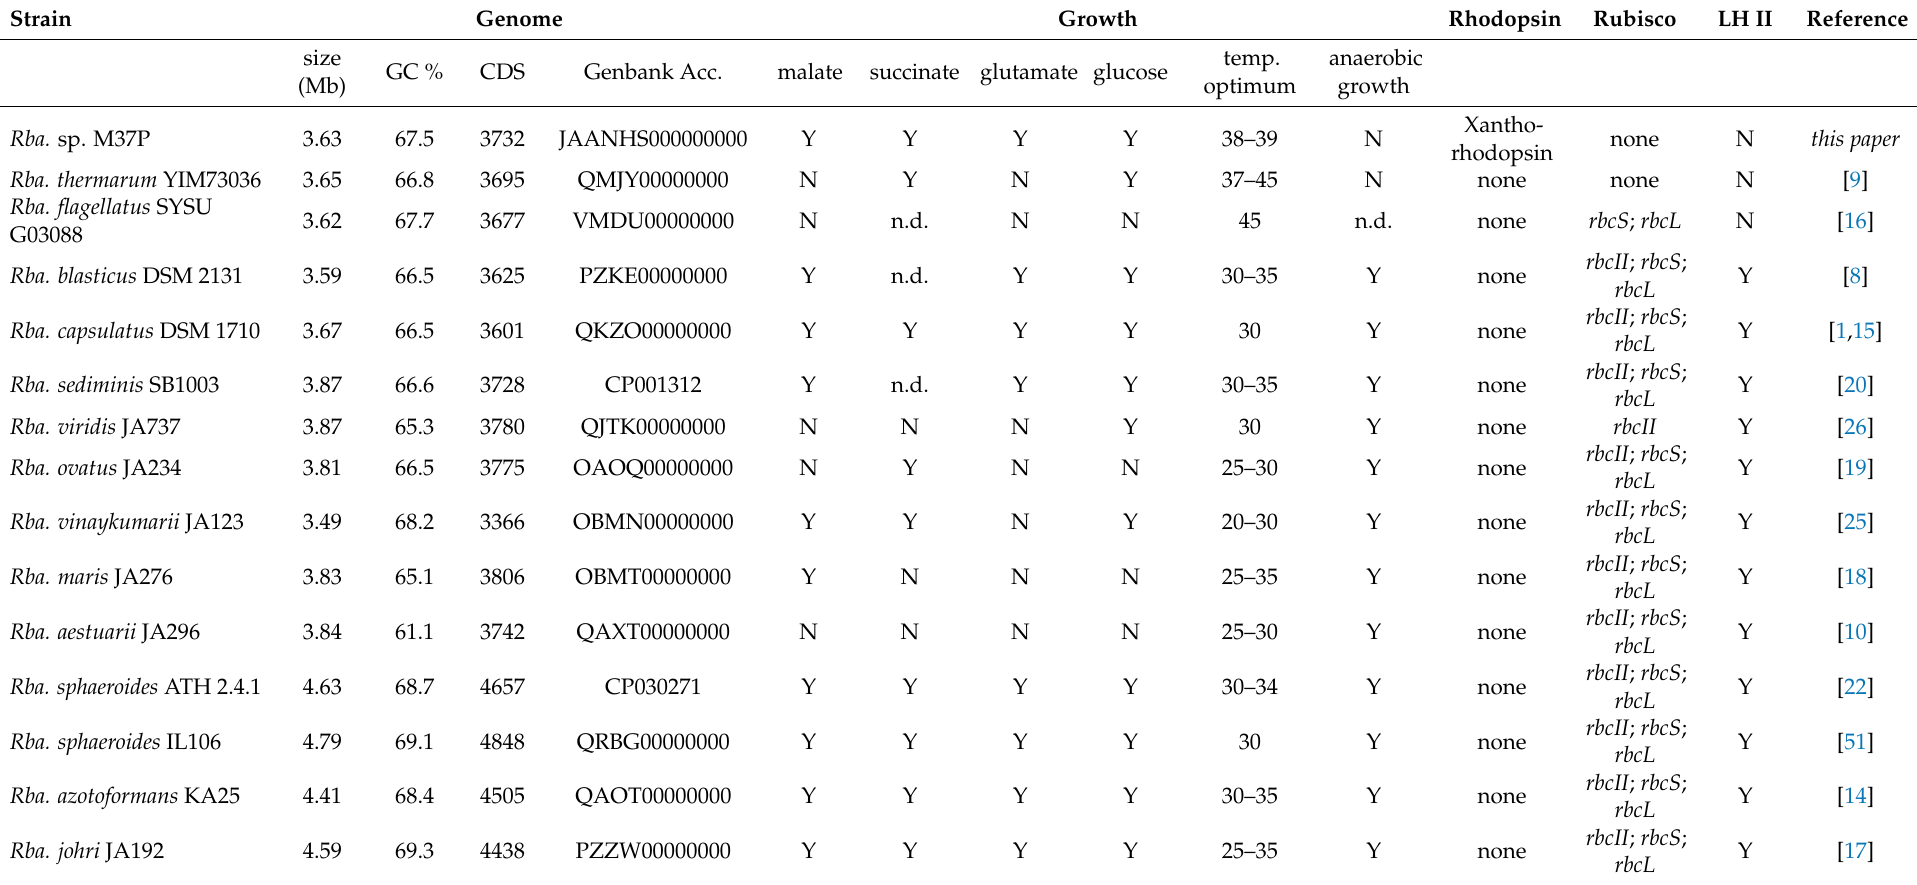
Table 1. Genomic and growth properties of Rhodobacter species. References where the growth data were obtained are included in the table. Other data were obtained from NCBI GenBank and genome analysis performed in PATRIC [32]. LH II = Light Harvesting complex II; Y = positive; N = negative; n.d. = not determined or not available in